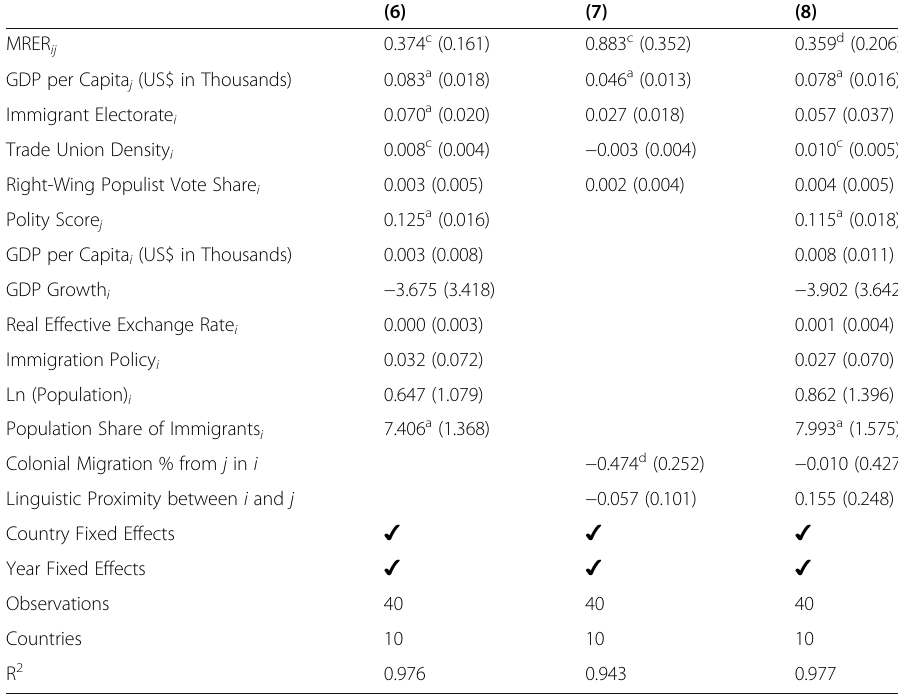
Table 2 Individual equality dimension robustness checks (1980 –